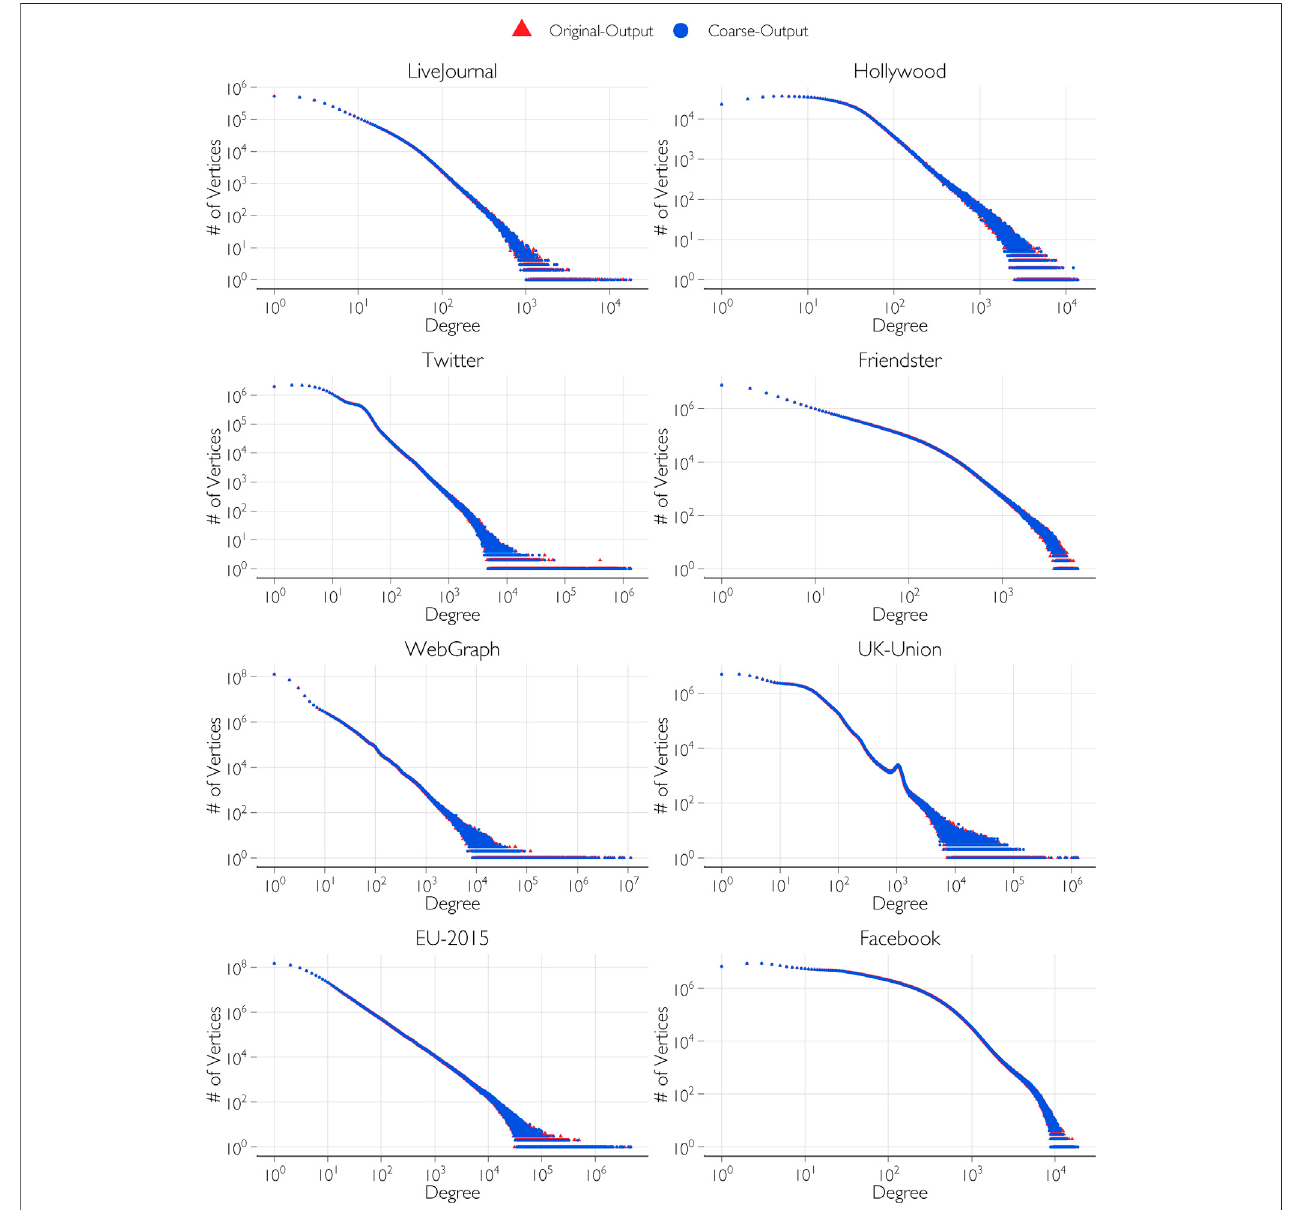
FIGURE 9 | Validating the output degree distribution from coarsened input distributions by comparison with that from original input distributions.